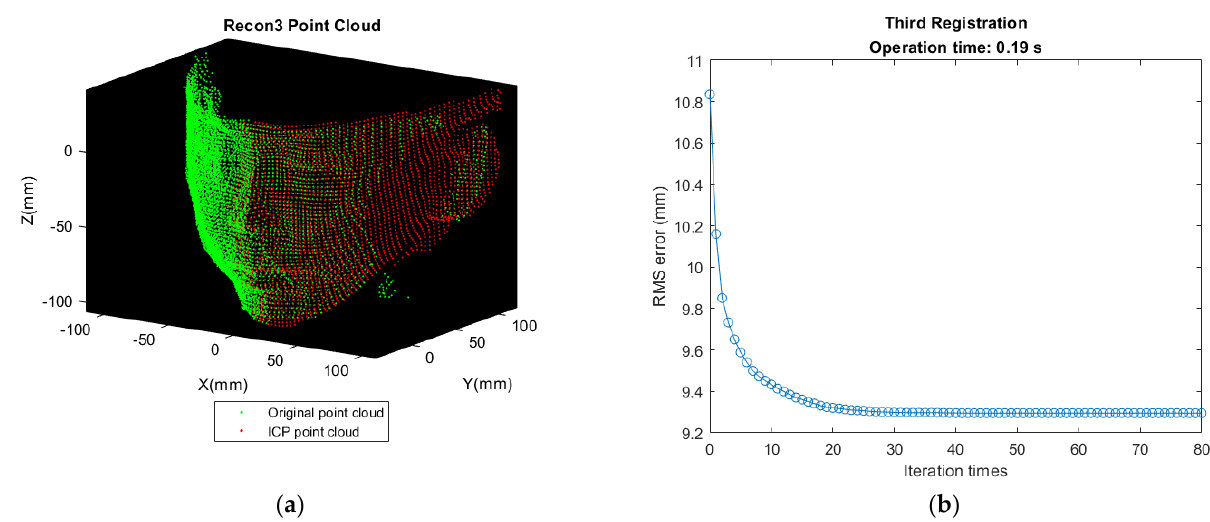
Figure 14. Result of third registration and deviation. ( a ) Recon 3 Cloud shows that some losing information is compensated by D point cloud. ( b ) The RMS error is larger because of sparser distribution of points and more outliers on the right face.